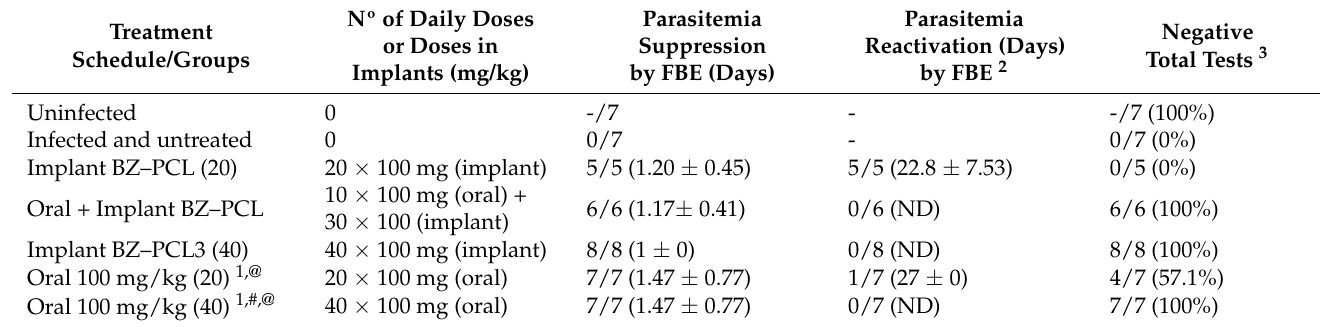
Table 3. Efficacy of treatment with benznidazole subcutaneous polymeric implants and/or adminis- tered by oral route in the course of infection of mice infected with Y & strain of Trypanosoma cruzi .